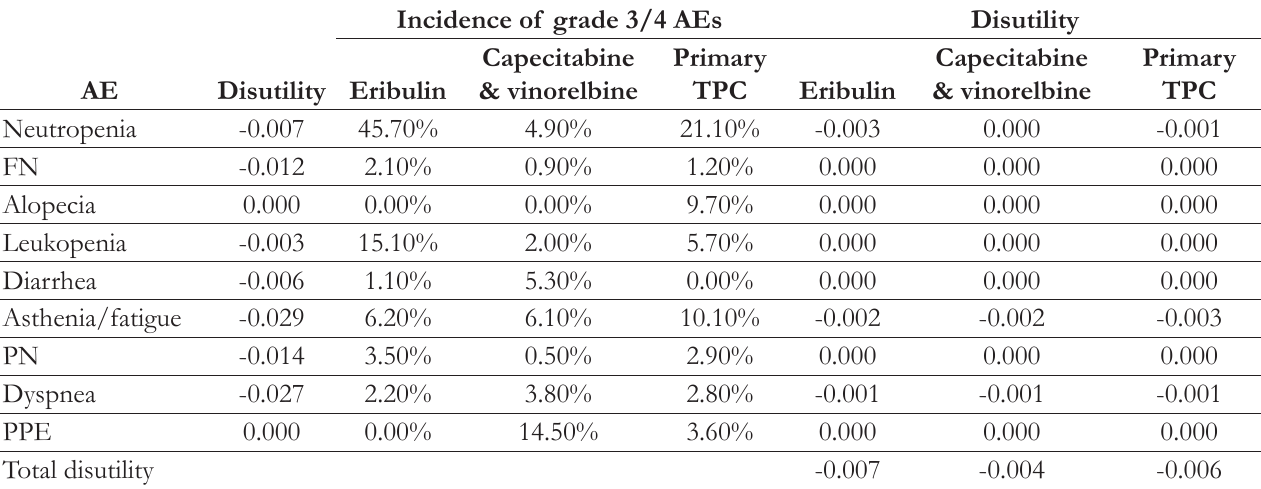
Table 5. Annual Disutility Scores for Adverse